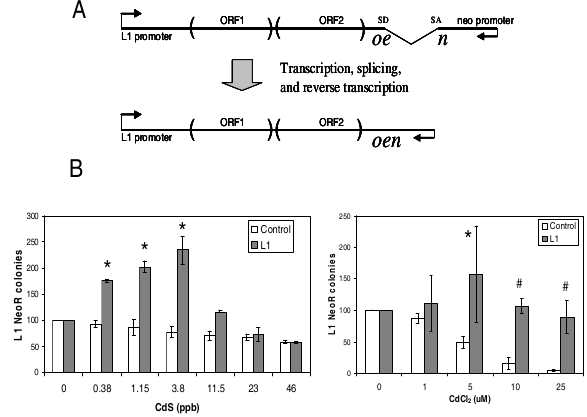
Figure 1: Stimulation of L1 retrotransposition by particulate and soluble